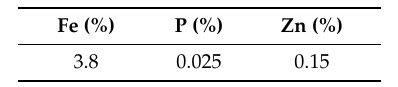
Table 3. Composition of Cu matrix in alloying element-enriched regions.